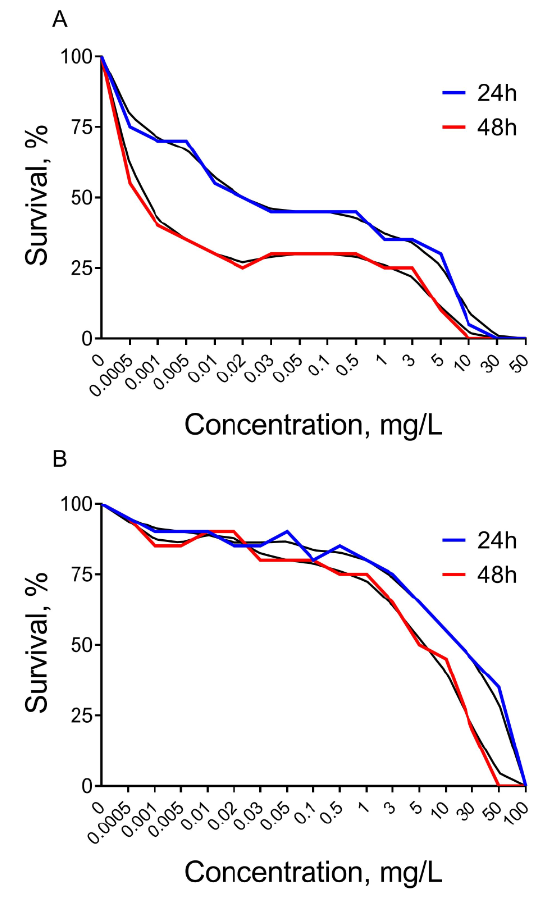
Figure 1: The mortality rate of Daphnia magna under 24 and 48 hours of exposure to Roundup ( A ) and Atrazine ( B ) treatments 0.0005-100 mg/L